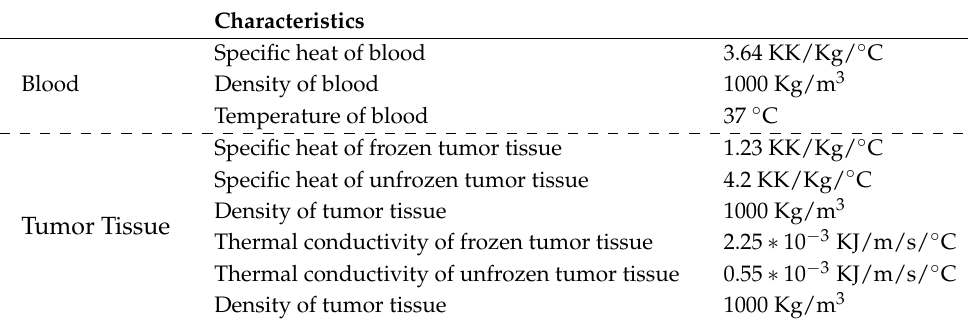
Table 1. Thermal properties of tissues and blood